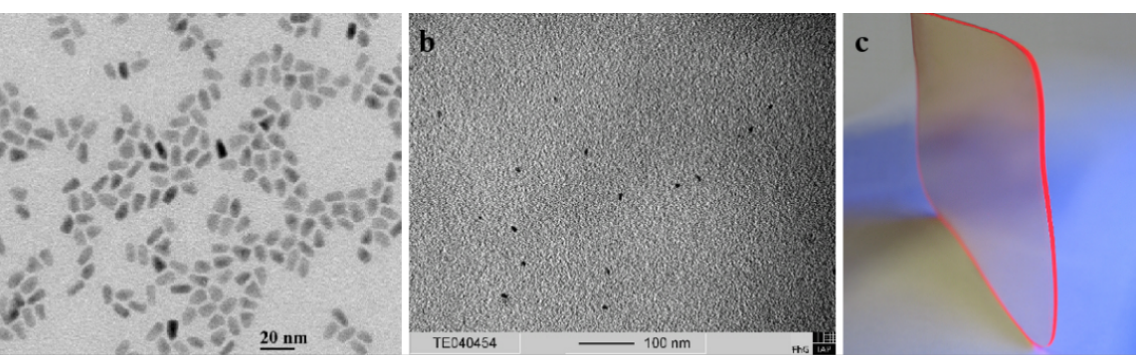
Figure 4: a) TEM image of CdSe/CdS nanorods (aspect ratio 6) b) in the NR/P(LMA- co -EGDM) composite and c) a photo of this nanocomposite (0.05 wt % NRs) showing bright luminescence already in daylight.